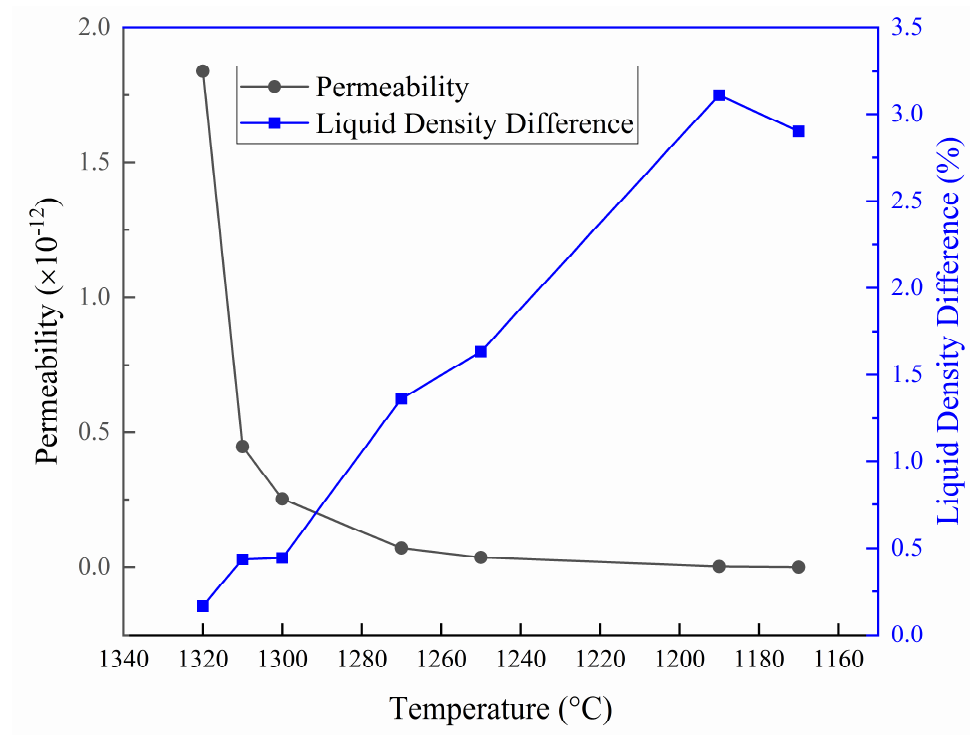
Figure 8. The permeability and the relative liquid density difference during solidification at different temperatures.